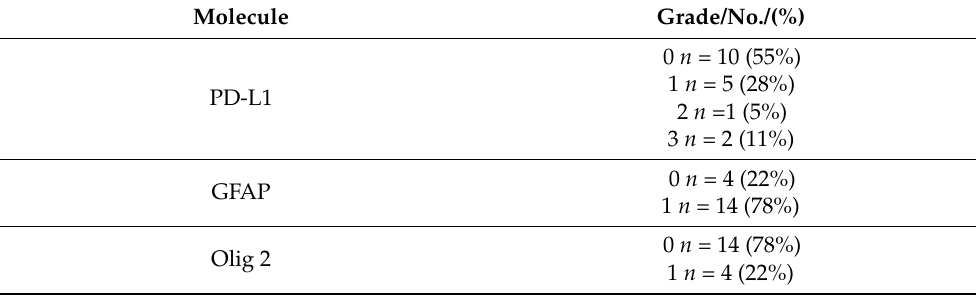
Table 4. Percentage distribution of molecules expression among the GBM pediatric cohort ( N =